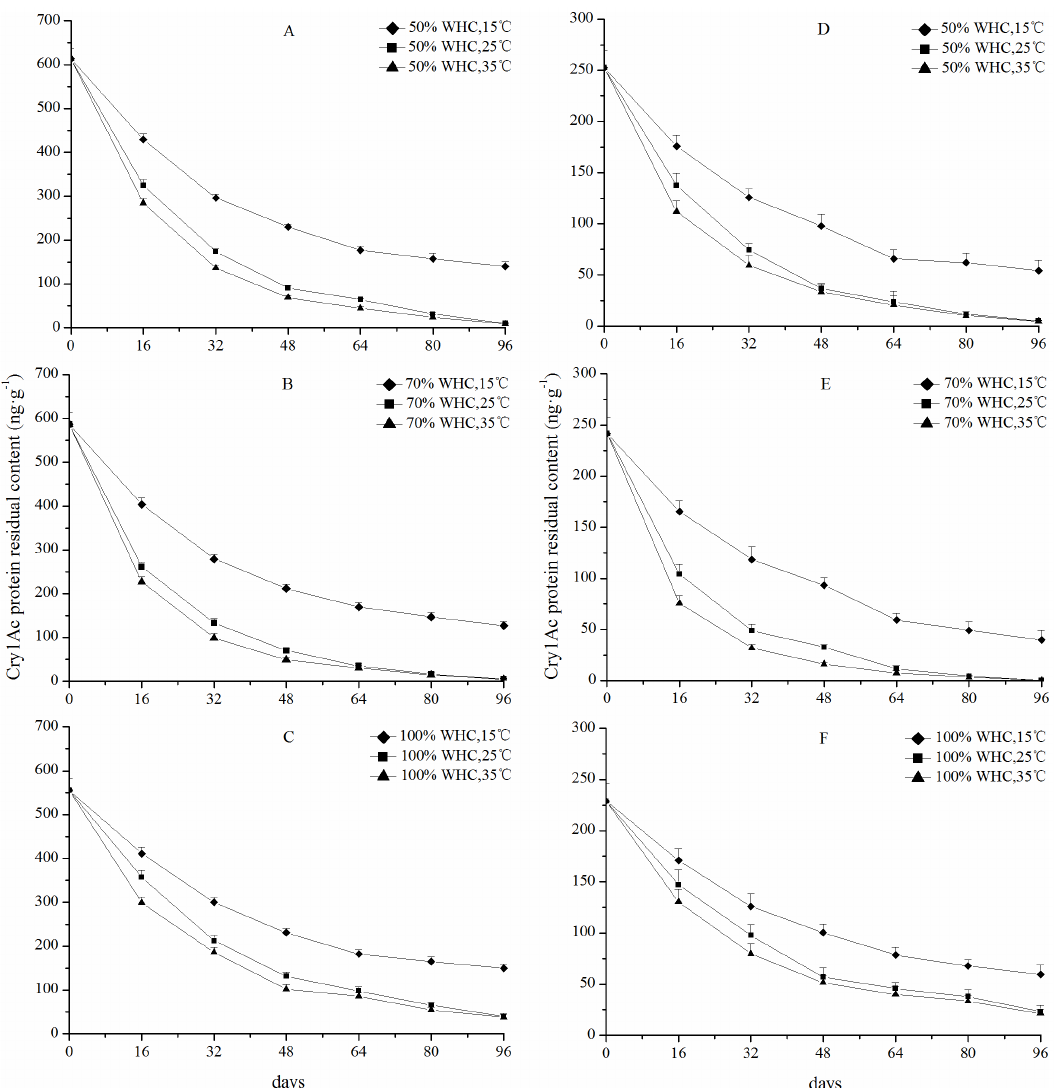
Fig. 1. The degradation dynamics of Cry1Ab protein in leaves (A, B, C) and buds (D, E, F) with the soil same water content and different temperatures settings. The data are expressed as the mean of three replicates ¡ standard